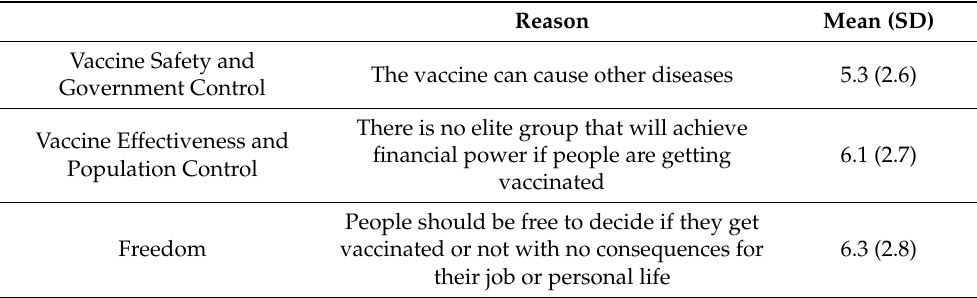
Table 2. Top Overall